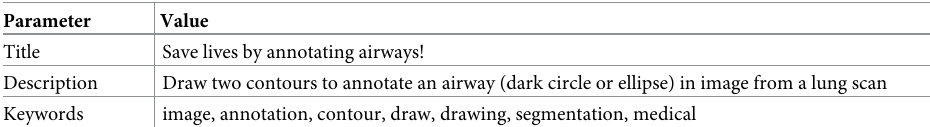
Table 1. Details of HIT on Amazon Mechanical Turk.